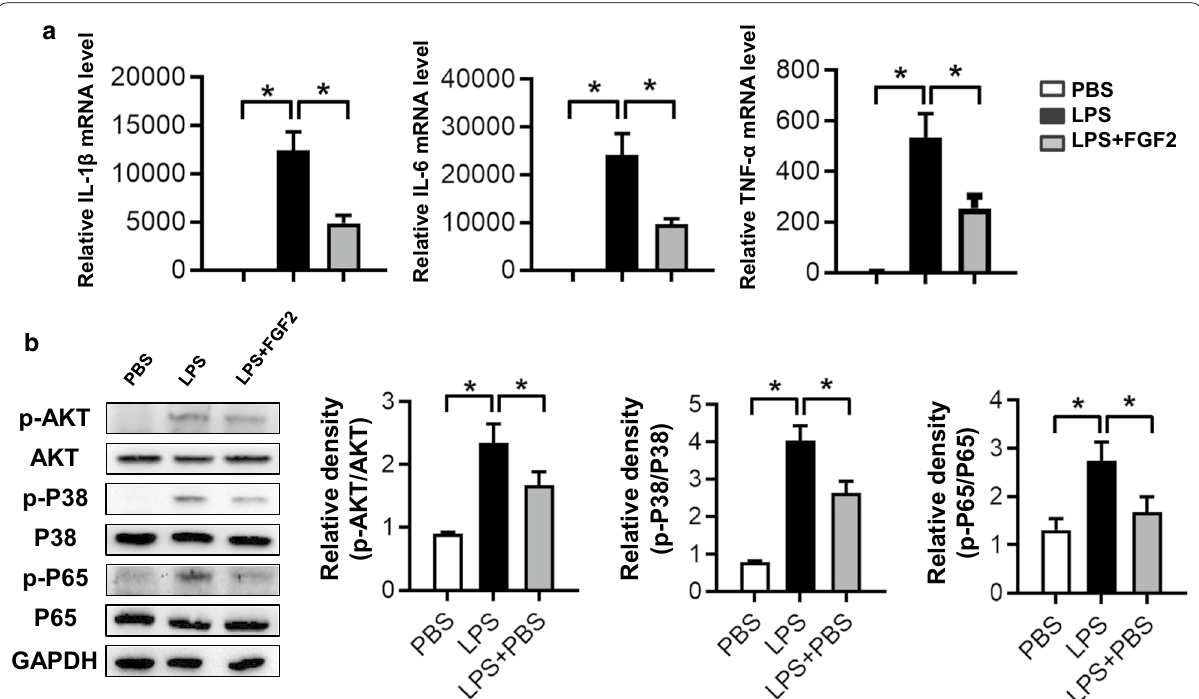
Fig. 6 The LPS-induced proinflammatory mediators in PMs were controlled by FGF administration. a The mRNA expressions of IL-1β, IL-6 and TNF-α in PMs stimulated by LPS (1 μg/ml) for 6 h with or without FGF2 (50 ng/ml) administration (n P38, p-AKT, AKT, p-P65 and P65 in PMs stimulated by LPS for 0.5 h were measured by western blot and relative densities were quantified (n group, β-actin was used as a internal control). Data are represented as mean